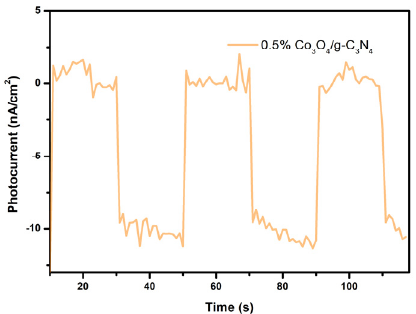
Figure 9. The photocurrent measurement spectra of the 0.5% Co 3 O 4 /g-C 3 N 4 catalysts.